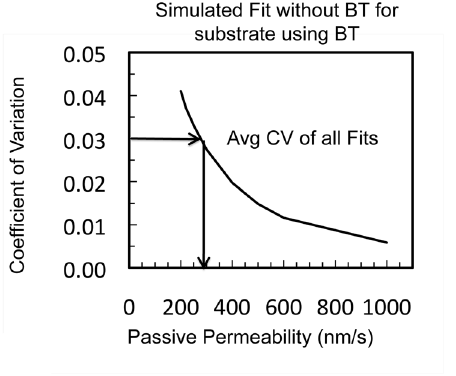
Figure 8. Simulation of + GF120918 passive permeabilities where the kinetic necessity of a basolateral digoxin uptake transporter could be validated. Simulated transport data was created across the MDCK-MDR1-NKI cells for a virtual hybrid molecule with the P-gp rate constants of verapamil and the basolateral transporter clearance of loperamide (k A =0, k B =100 s 2 1 ). The passive permeability was varied between 200–1000 nm/s. The substrate concentration range used for fitting was 3 nM to 30 m M. The simulated data were analyzed using only P-gp, i.e. only k r and k 2 were used to fit the data. The coefficient of variation, CV, for the best fit at each passive permeability value was obtained. When the fits deteriorated to a coefficient of variation, CV, above 0.03, or 3%, the kinetic need for the basolateral digoxin uptake transporter becomes plausible [13].